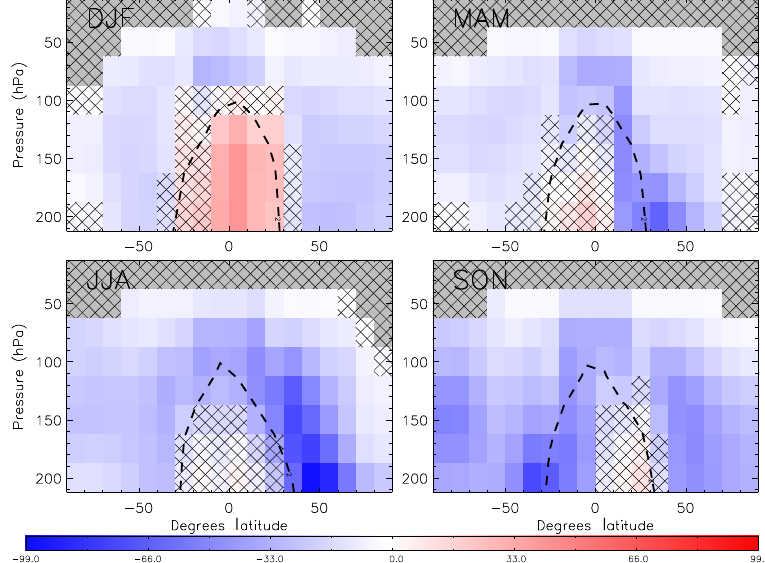
Figure 16. Difference in zonal mean PAN (pptv) between the TOMCAT model (with IMK AKs applied) and observed IMK MIPAS PAN for 2007–2008 in DJF, MAM, JJA, and SON. Hatching represents non-significant differences.